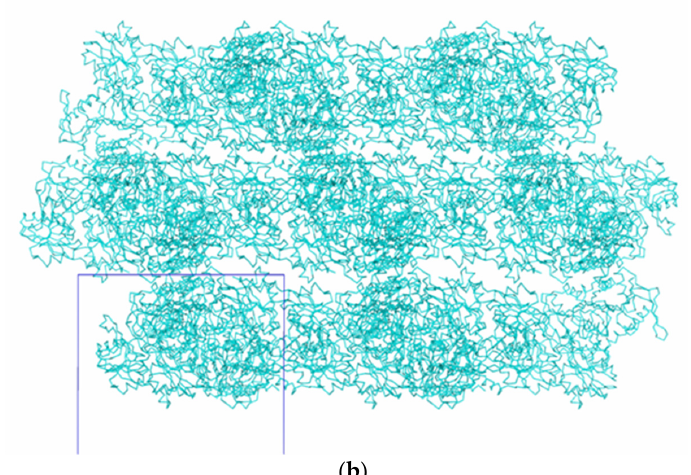
Figure 7. Packing of TthPRPPS2 molecules in the R3 2 h crystal modification: view along the c axis ( a ); view in the direction perpendicular to the c axis ( b ). Matthews’s coefficients [24] for crystal structures belonging to space group R3 2 h and P 4 1 2 1 2 are 2.73 and 3.52 Å3/Da, respectively, which indicates a higher solvent content in the tetragonal structure (65.03%), as compared to the rhombohedral one (55.00%). Comparison of the spatial structures and conformations of phosphoribosyl pyro- phosphate synthetase molecules from the thermophilic bacterium Thermus thermophilus HB27, obtained at a resolution of 1.85 Å (rhombohedral crystals of the enzyme, space group R3 2 -h ) and at a resolution of 2.2 Å (tetragonal crystals, space group Р 4 1 2 1 2 ), revealed a number of differences. In the rhombohedral crystal modification, the conformation of independent subunits in the region of the active center differs in location and degree of ordering of the catalytic loop, which regulates the degree of openness of the active center. One of the subunits has a closed conformation of the active center, similar to the confor- mation of one of the subunits in tetragonal crystals.